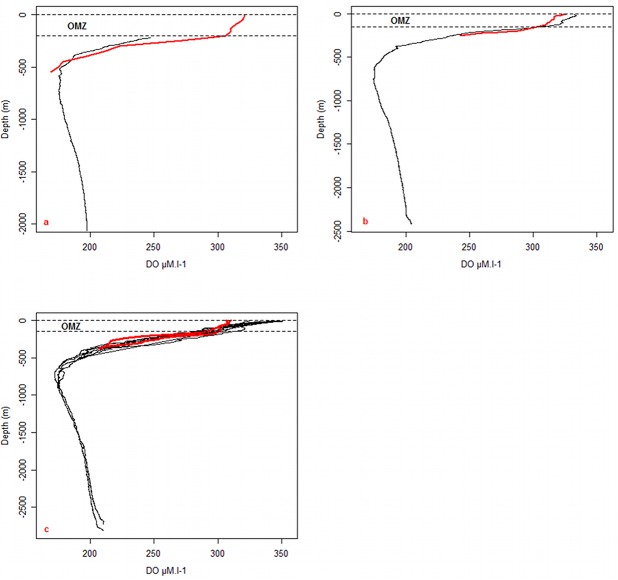
Comparison between the seal (red lines) and the nearest Keops Oxygen-Depth profiles (black lines).A gap between the profiles appears in the Oceanic Mixed Layer (OML). The letters a,b & c correspond to the profiles located in the Fig 2.